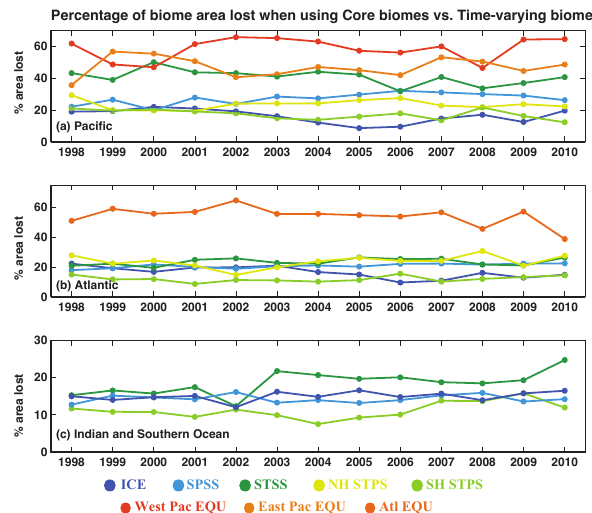
Figure 4. Percentage of biome area lost each year if using core biomes as compared to time-varying biomes for (a) Pacific Ocean, (b) Atlantic Ocean, and (c) Southern and Indian oceans. Dark blue: ICE; cyan: SPSS; green: STSS; yellow: Northern Hemisphere STPS; orange: EQU; light green: Southern Hemisphere STPS.